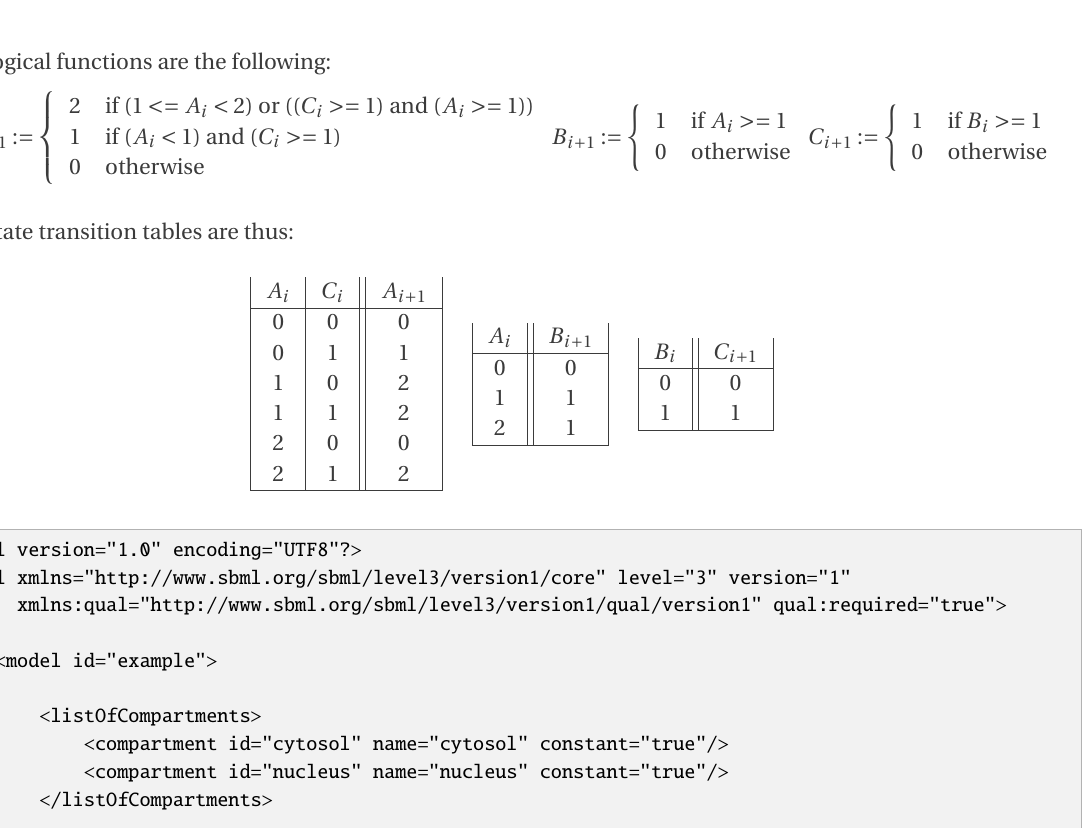
Figure 4: A simple Logical Regulatory